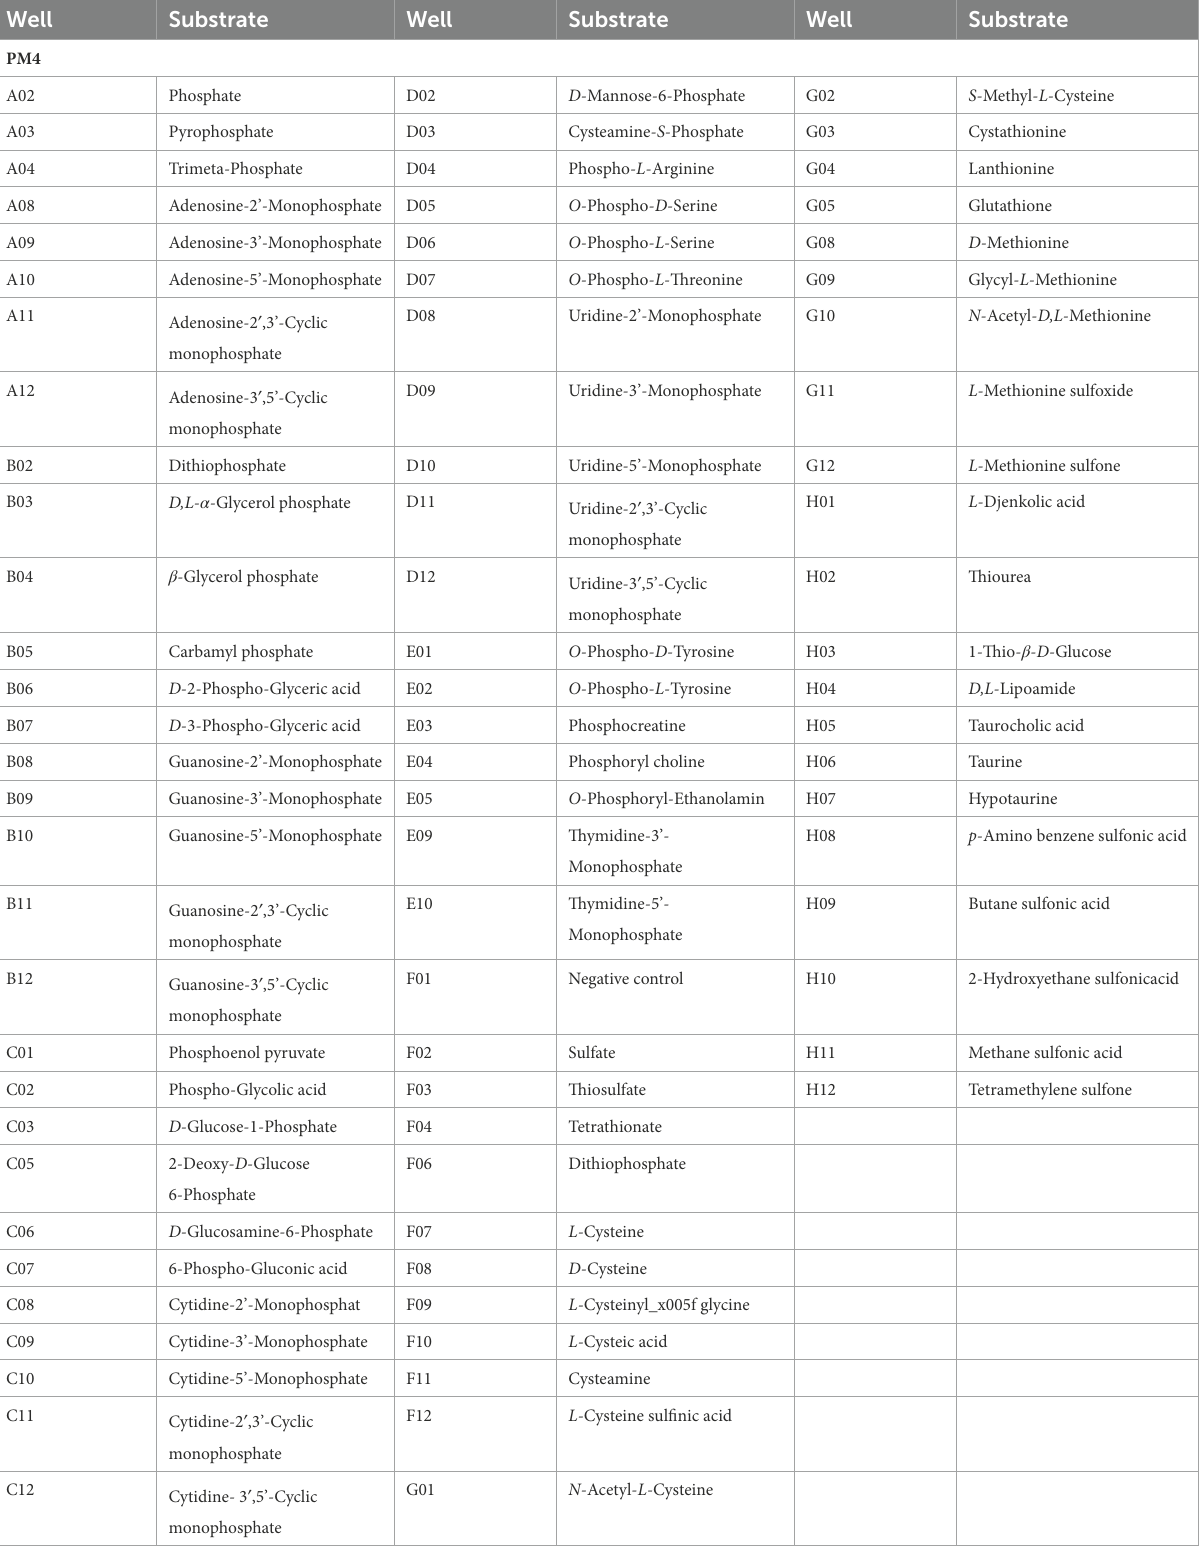
TABLE 3 Substrates in PM 4 phosphorus and sulfur source Micro plates significantly supported the growth of Rhizopus oryzae.